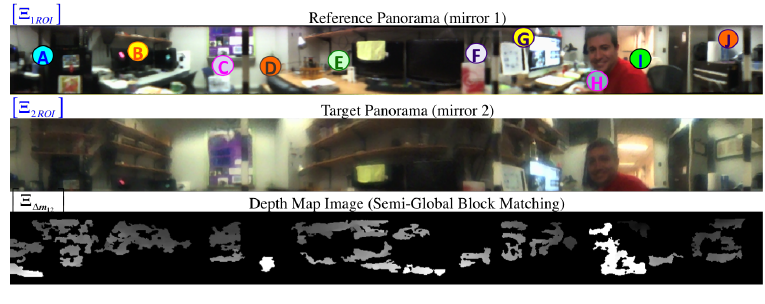
Figure 20. A 3-D dense point cloud computed out of the synthetic model that rendered the omnidirectional image shown in Figure 2b. Pixel correspondences are established via the panoramic depth map visualized in Figure 15. The 3D point triangulation implements the common perpendicular midpoint method indicated in Section 5.2.1. The position of the omnistereo sensor mounted on the quadrotor is annotated as frame [ C ] with respect to the scene’s coordinates frame [ S ] . ( a ) 3D visualization of the point cloud (the quadrotor with the omnistereo rig has been added for visualization only); ( b ) Orthographic projection of the point cloud to the XY-plane of the visualization grid.